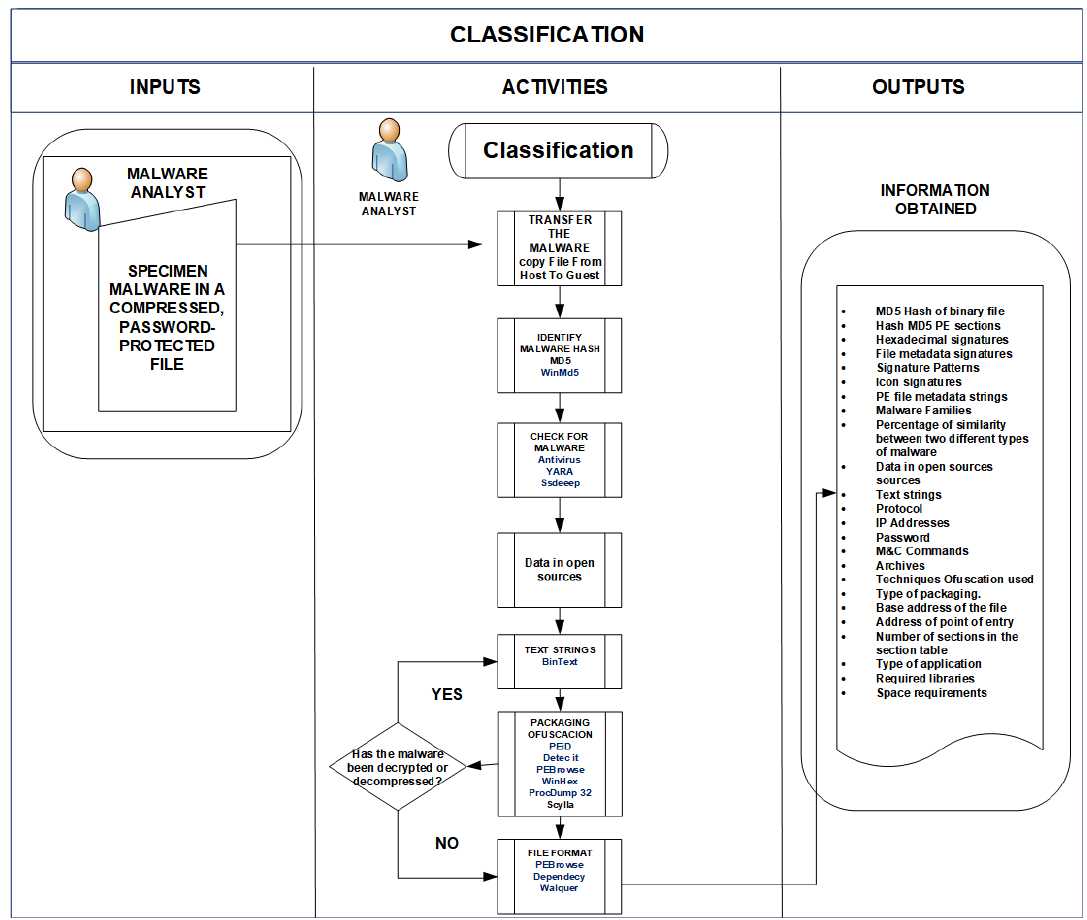
Figure 5. Diagram of the classification step.